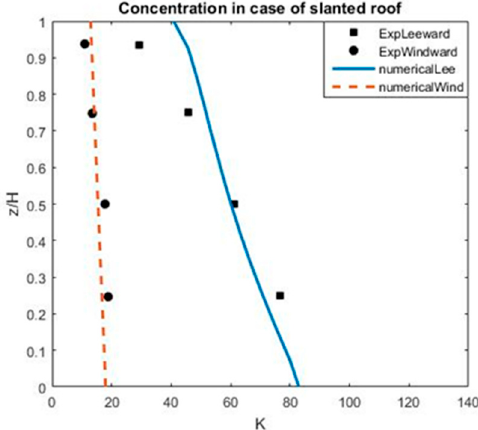
Figure 20. A comparison of the dimensionless concentration K between experiment and computation (with Z H / H = 0.5) at the leeward side (x / B = 0.25) and at the windward side (x / B = 0.75).